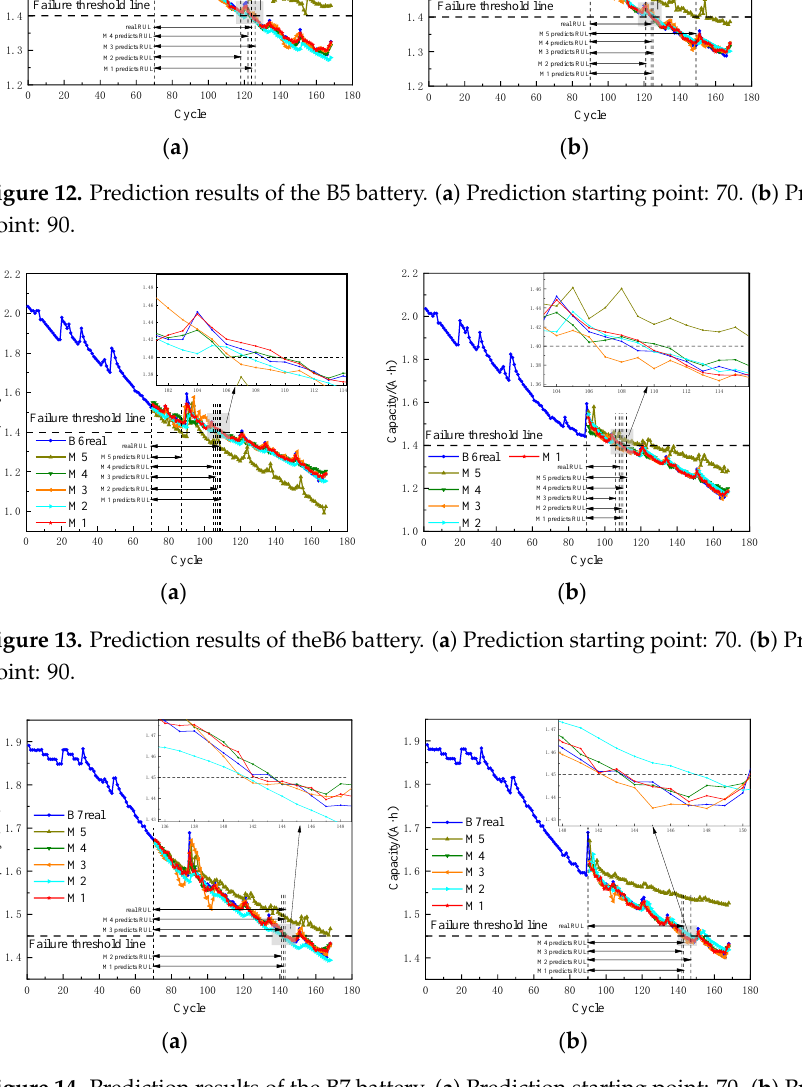
( b ) Figure 15. Prediction results of the B18 battery. ( a ) Prediction starting point: 55. ( b ) Prediction start- ing point: 70. A comparison of the evaluation indicators under different methods is shown in Table 4. Table 4. A comparison of the evaluation indicators. Battery